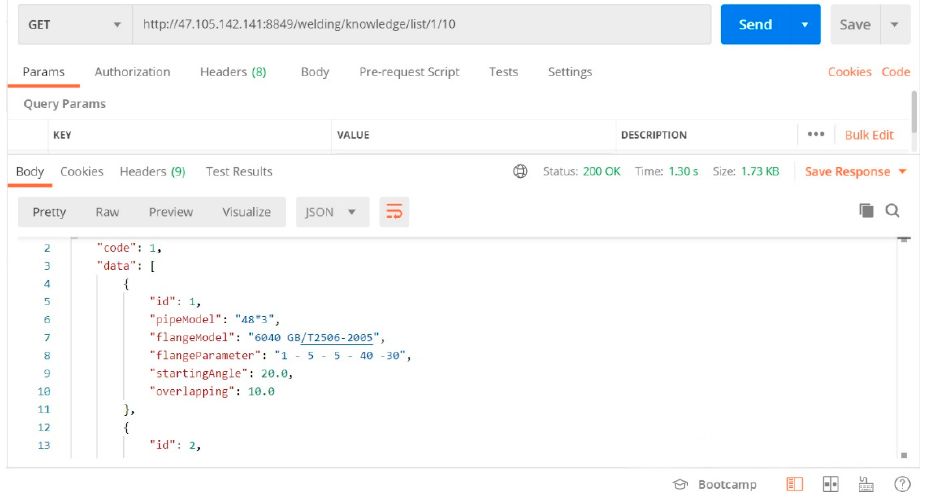
Figure 3. A link sample of digital twin system data structure.